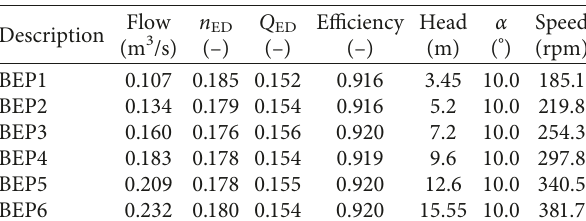
Table 1: Measurement